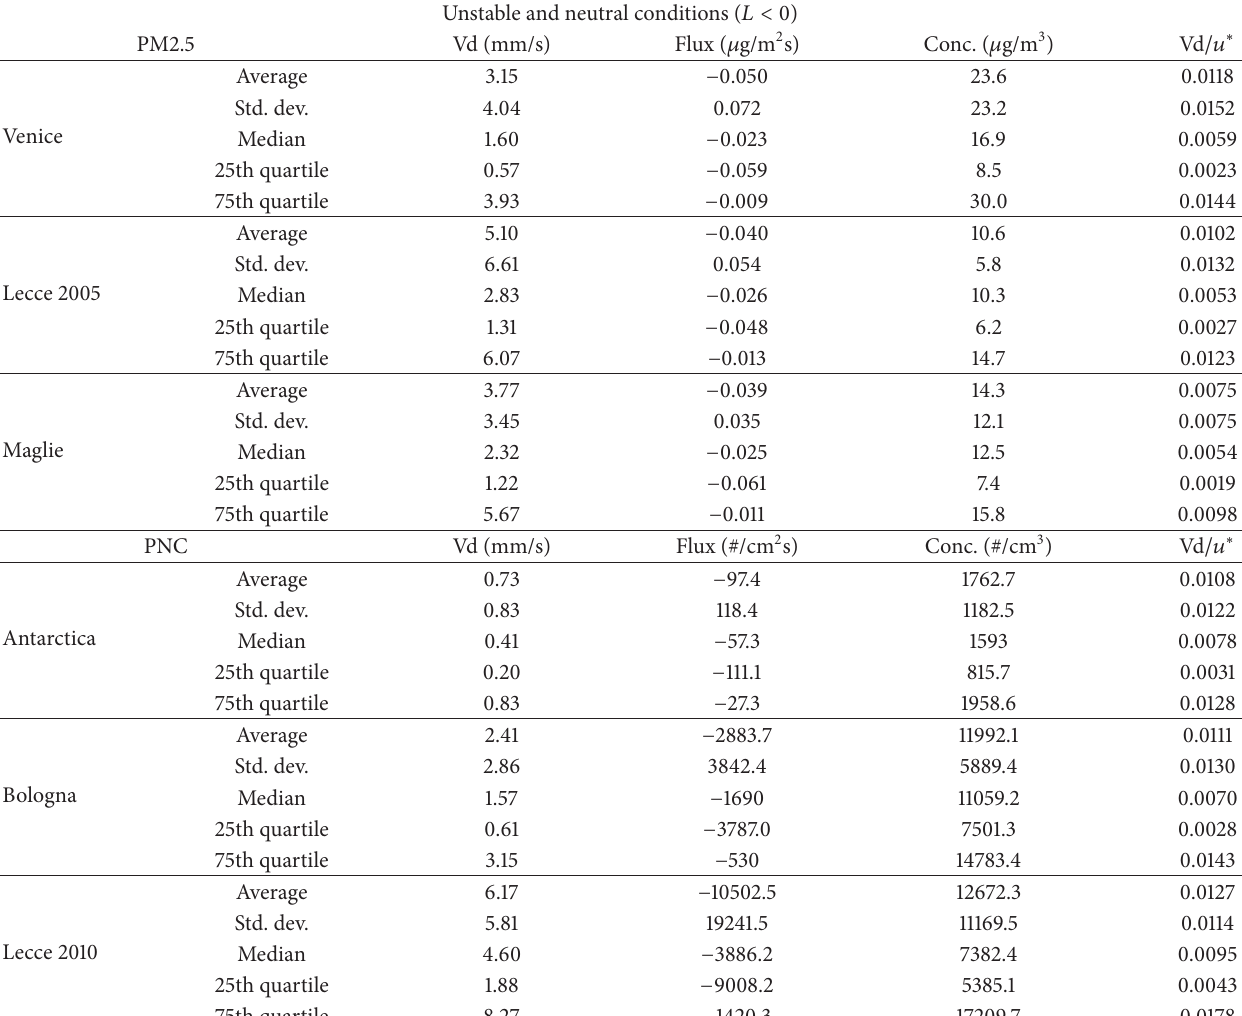
Table 4: Average (with standard deviation) and median (with 25th and 75th quartiles) values are reported for deposition velocities, fluxes, concentrations, and normalized deposition velocities for each site, separating PM2.5 from particle number data. In this table data is selected for unstable atmospheric stability cases 𝐿 < 0 (including quasi-neutral